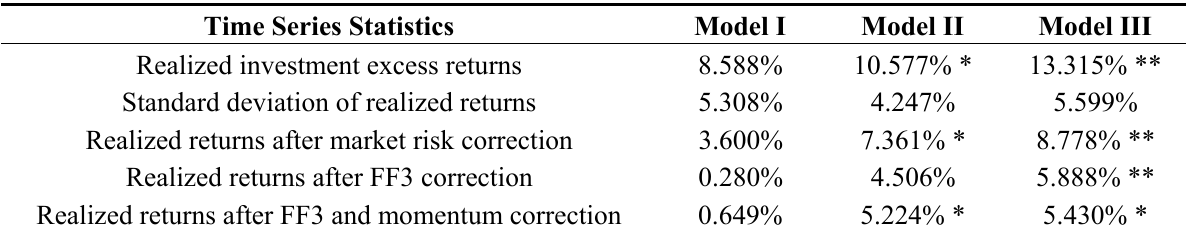
Table 7. Forecasting results for size